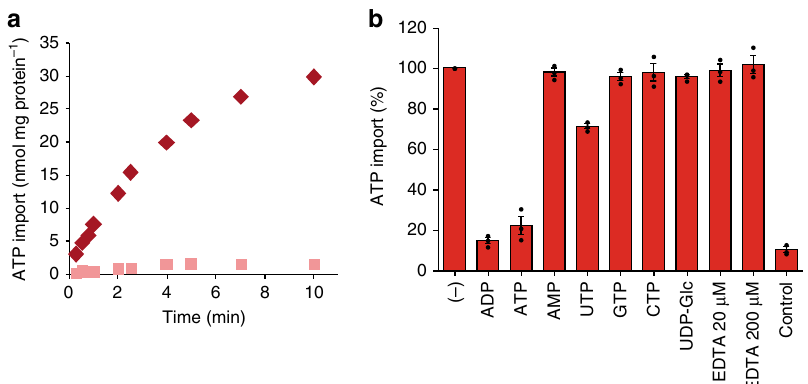
Fig. 4 ATP transport into proteoliposomes with the full complement of mammalian ER membrane proteins. Proteoliposomes harboring porcine or canine pancreatic rough ER membrane proteins were prepared as described in Methods. a Time dependent accumulation of 50 µ M [ α 32 P]-ATP in unloaded (pink) or preloaded (10 mM ADP; red) proteoliposomes, which were derived from porcine pancreatic microsomes by treaytment with puromycin and high salt (PKRM). Related substrate saturation experiments and corresponding Eadie – Hofstee analyses are shown in Supplementary Fig. 5. All data are reported as the mean of at least three independent experiments. b Proteoliposomes were preloaded with 10 mM ADP (except for the bar labeled control, which refers to unloaded proteoliposomes). [ α 32 P]-ATP was present at a concentration of 50 µ M. Each effector substance was given at a concentration of 500 µ M and uptake was terminated after 2 min. All data are reported as the mean of at least three independent experiments and are shown with the standard error of the mean